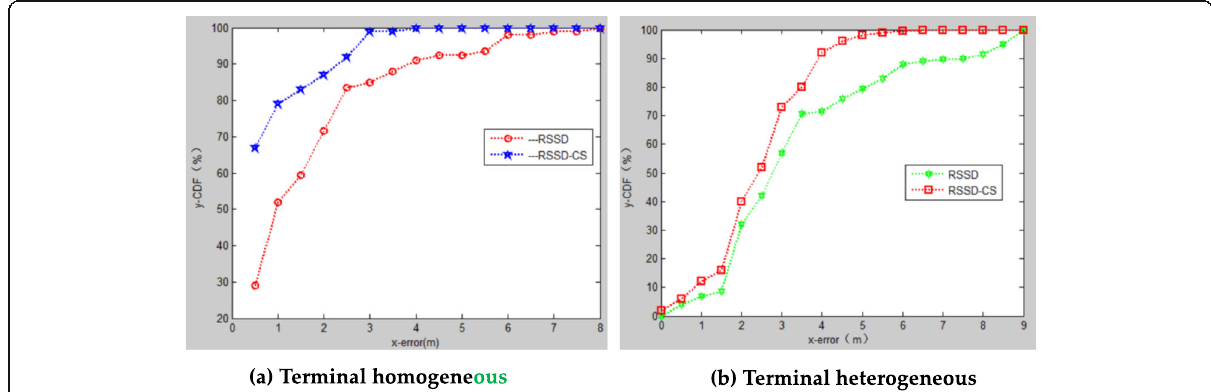
Fig. 7 Comparison of RSSD-CS localization performance. a Terminal homogeneity. b Terminal heterogeneous